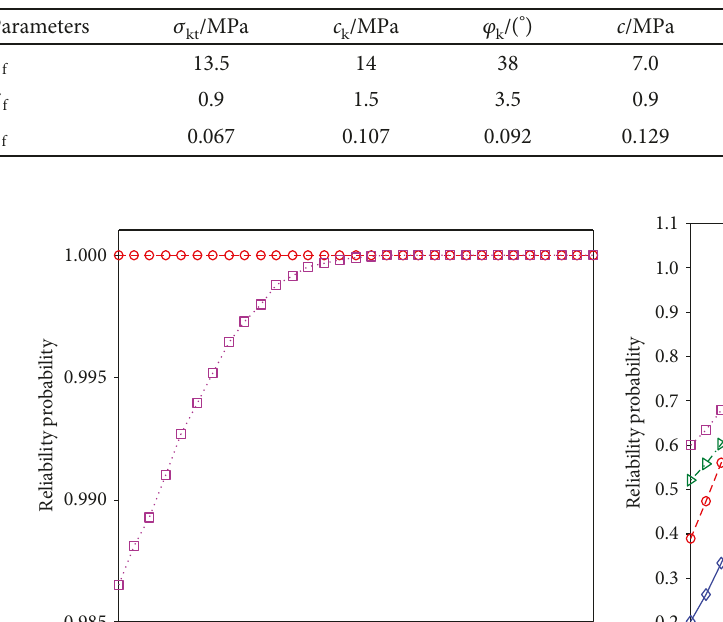
Table 1: Statistics of the random variables in the synthetic case.